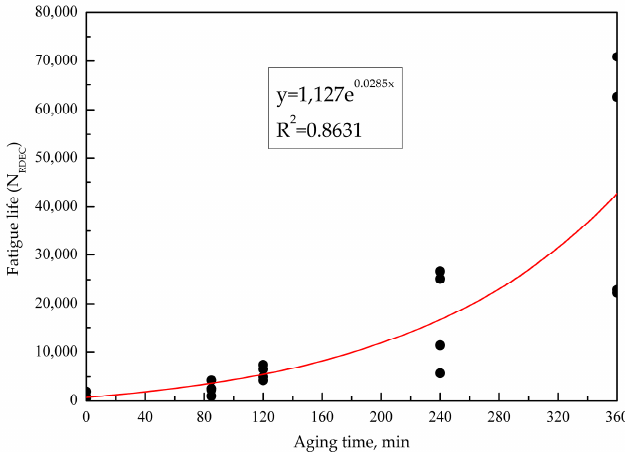
Figure 12. The relationship between fatigue life N RDEC and aging time.